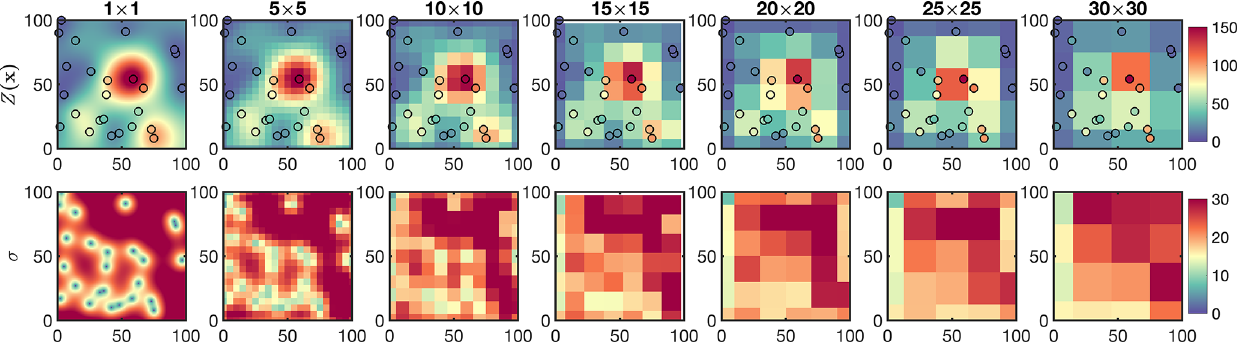
Figure 6. First row: C5Opt outputs convolved with an ideal box kernel with different sizes (1 × 1 up to 30 × 30) overlaid by the C5Opt optimum samples. Second row: the associated kriging errors convolved with the same kernel. The coarser the resolution is, the larger the discrepancy between the samples and the estimates is.